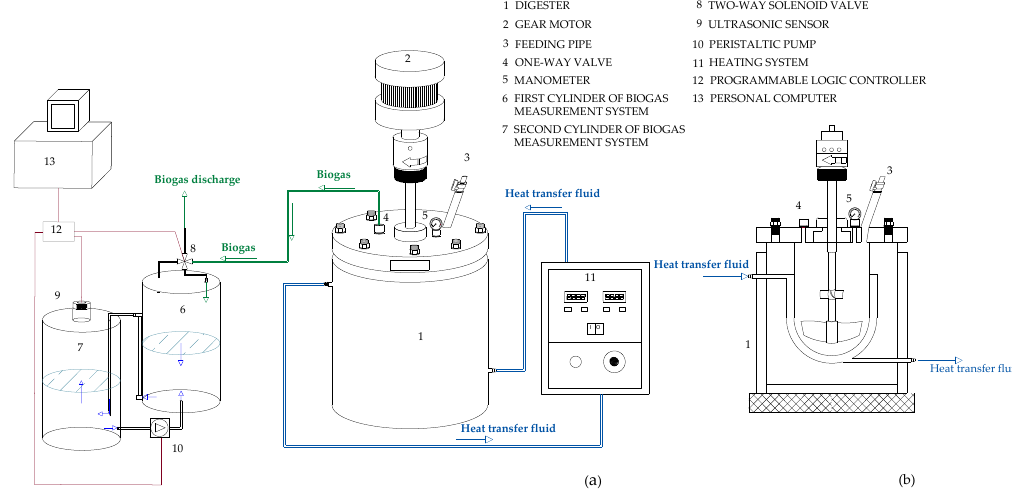
Figure 1. Schematic diagram of pilot plant ( a ), vertical section of completely stirred tank reactor (CSTR) ( b ).